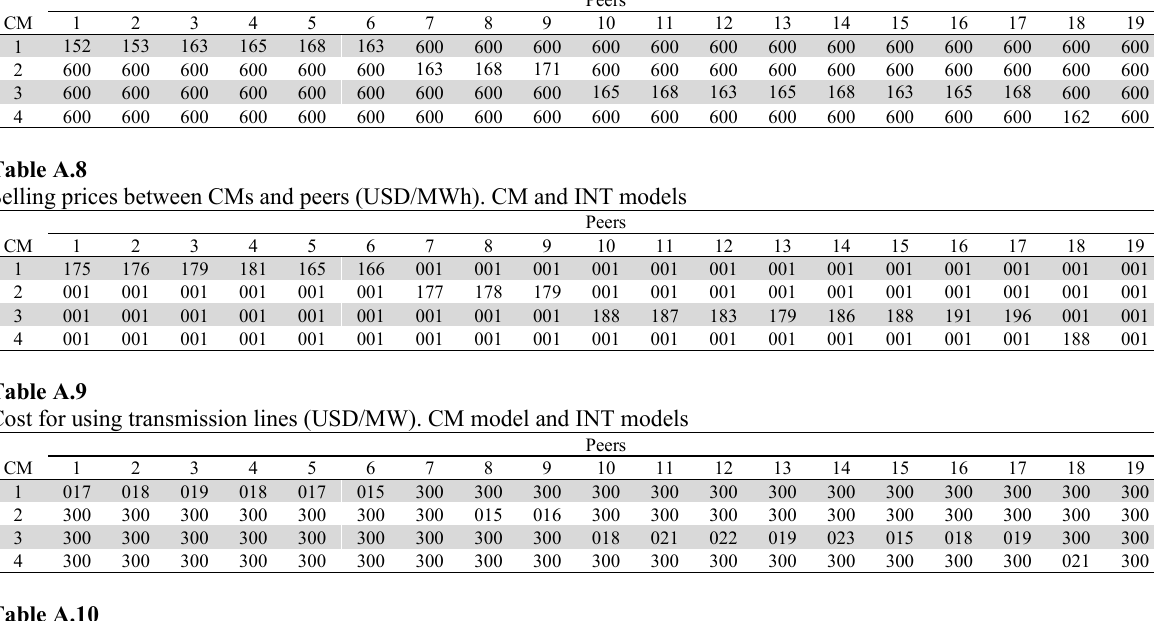
Buying costs between CMs and peers (USD/MWh). CM and INT models CM 1